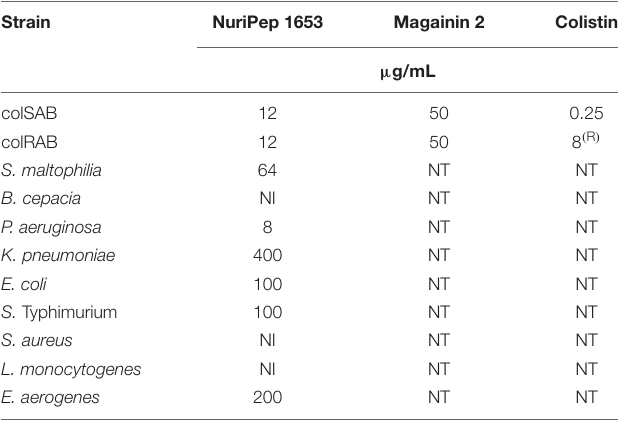
TABLE 2 | Complete elimination values of NuriPep 1653 against colSAB and colRAB as well as a range of Gram-negative and -positive pathogens. Strain